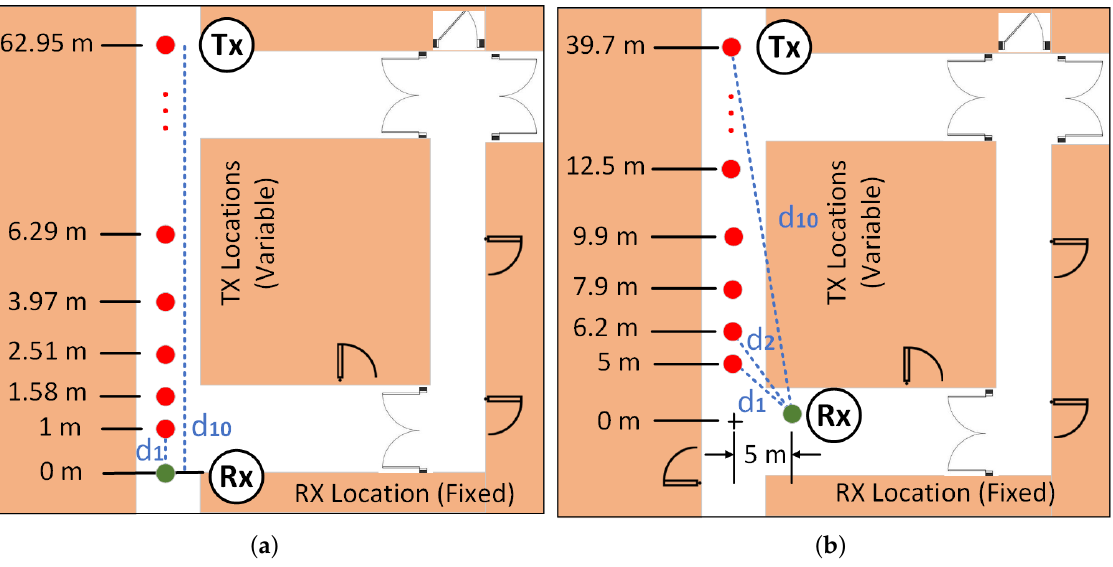
Figure 2. Measurement scenarios. ( a ) Scenario I—Line-of-Sight scenario, ( b ) Scenario II—Non-Line- of-Sight scenario.